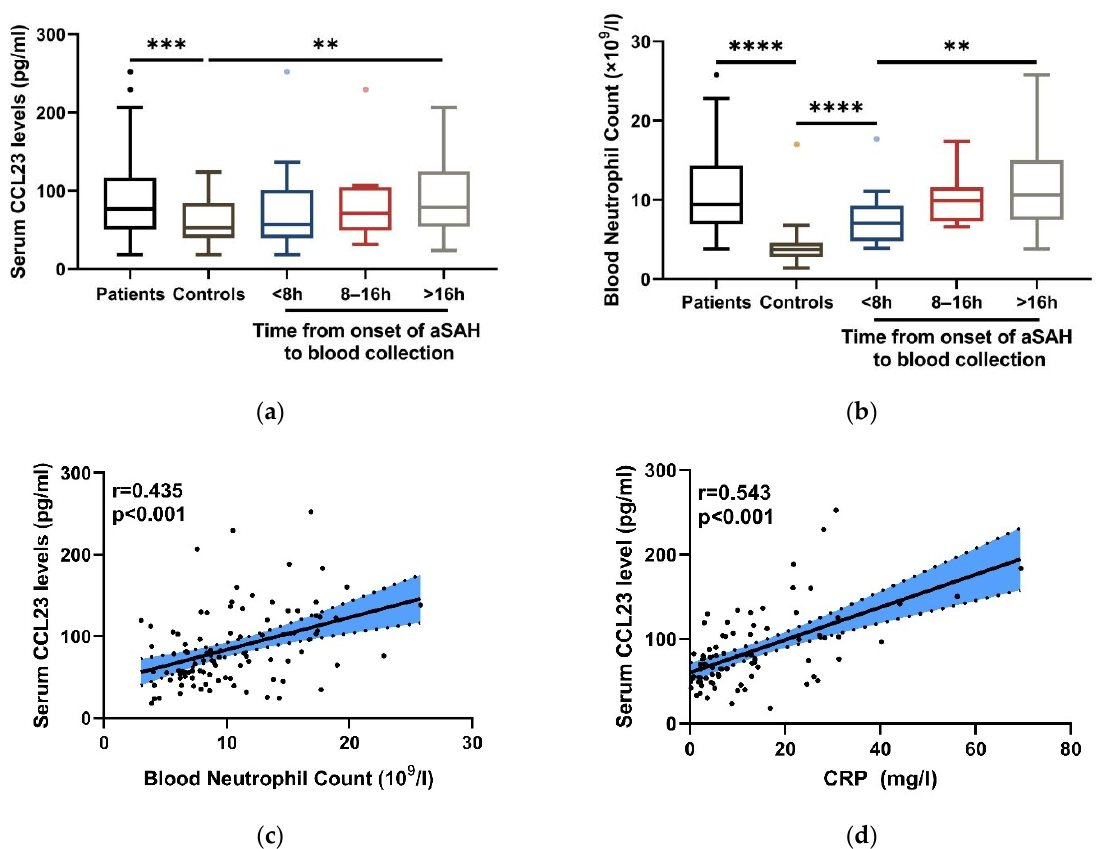
Figure 2. Association between serum CCL23 levels and inflammation after aSAH. ( a , b ) Boxplots show the change in serum CCL23 levels and blood neutrophil count in patients with aSAH and in controls. Boxplots represent Turkey, and points outside the whiskers are outliers; ** p < 0.01, *** p < 0.001, **** p < 0.0001. ( c , d ) Scatterplot and regression line show correlation between serum CCL23 levels and blood CRP levels, blood neutrophil count at admission. The blue areas represent 95%CI of the regression line; r means Spearmen’s correlation coefficient of two factors.